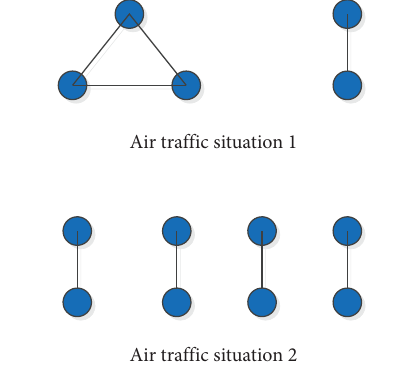
Figure 4: Air trafc situation classifcation.